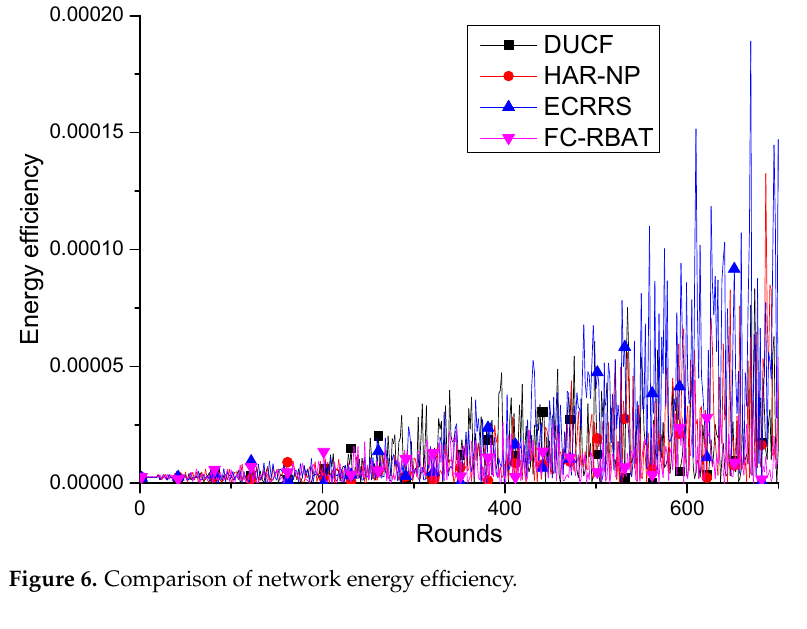
Figure 6. Comparison of network energy efficiency.